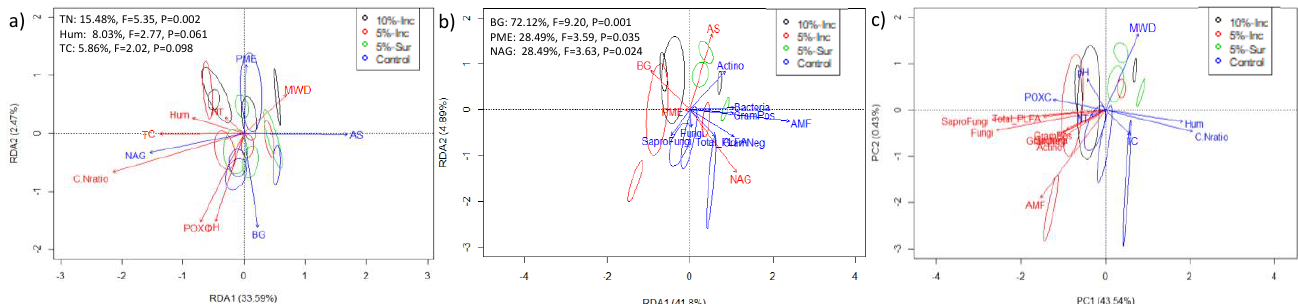
Figure 4. Redundancy analyses (RDA) of the correlations between ( a )-soil enzyme activities to soil properties, ( b )-the correlations between soil enzyme activities and microbial community composition indicated by FAME indicators